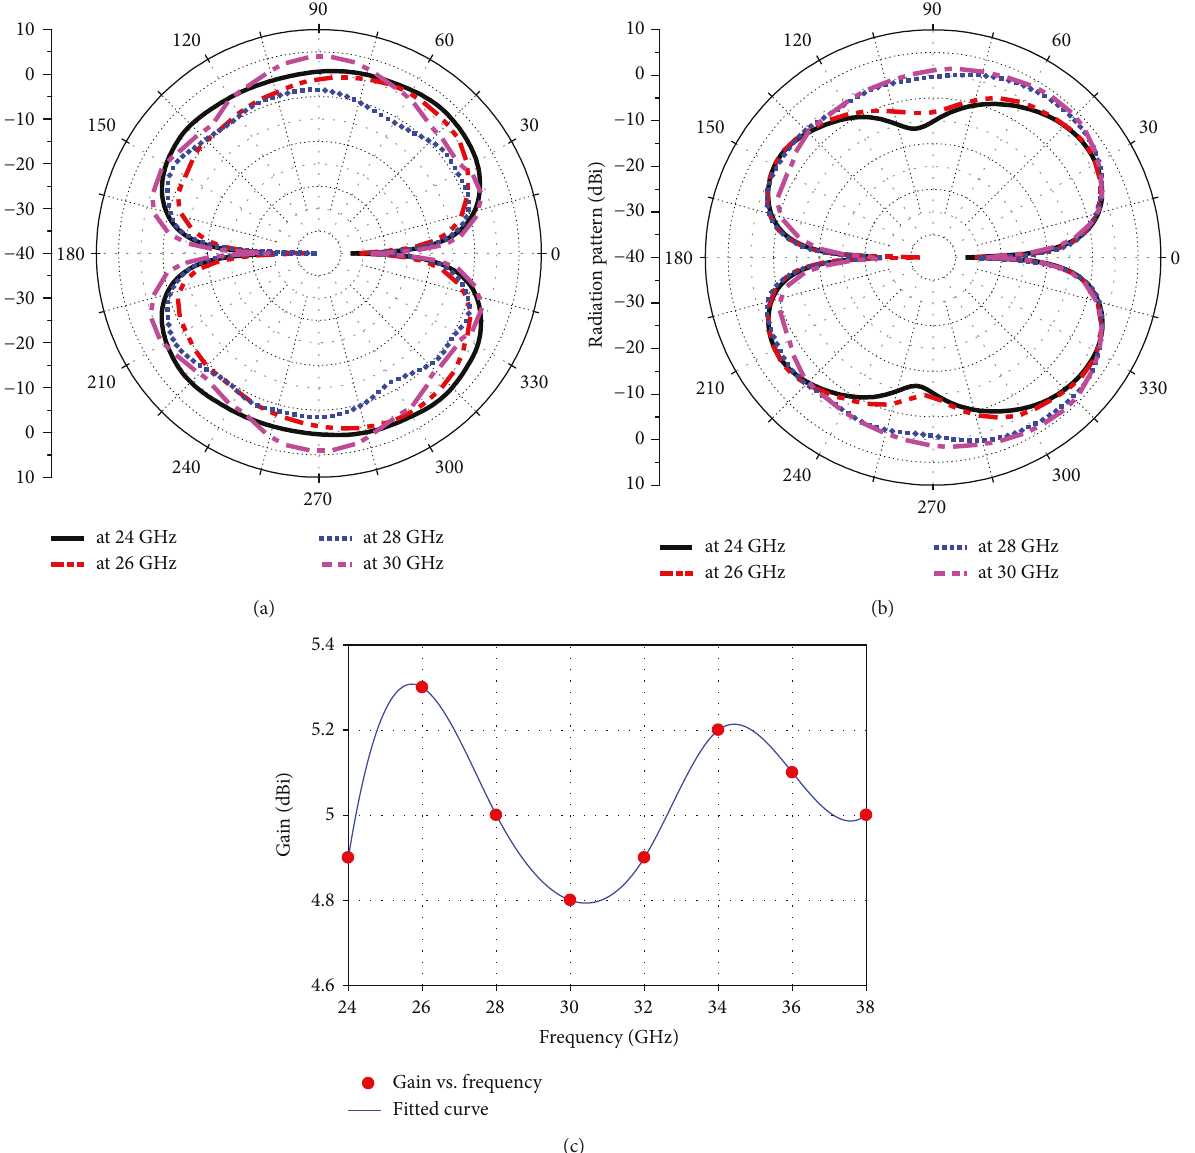
Figure 3: Simulated radiation patterns of the proposed antenna on the xoz-plane (a) and yoz-plane (b), simulated gain of the proposed antenna